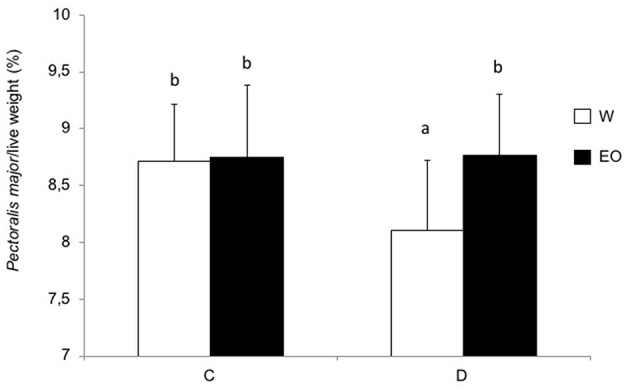
Chicken performance in experiment 2. Chicks were either directly placed in pens (C group) or delayed for 24 h (D group), and had ad libitum access to only water (W) or to water, and EO (EO). The histograms show P. major weight at 34 days of age for chickens that had ad libitum access to only water (W) or to water and EO (EO). The results express the mean and standard deviation. NS or p-values indicate statistical significance between the W and EO groups.